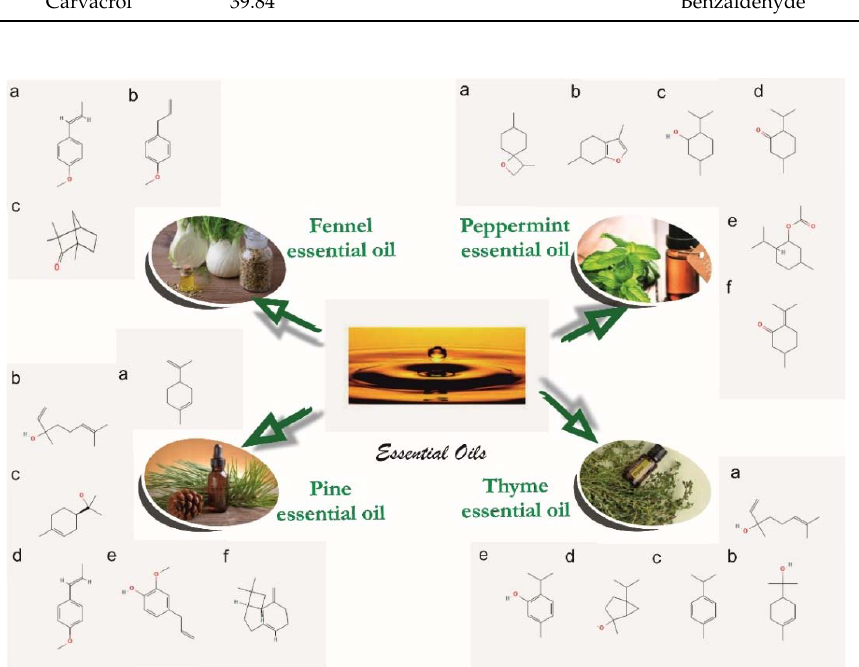
Figure 1. The composition of the essential